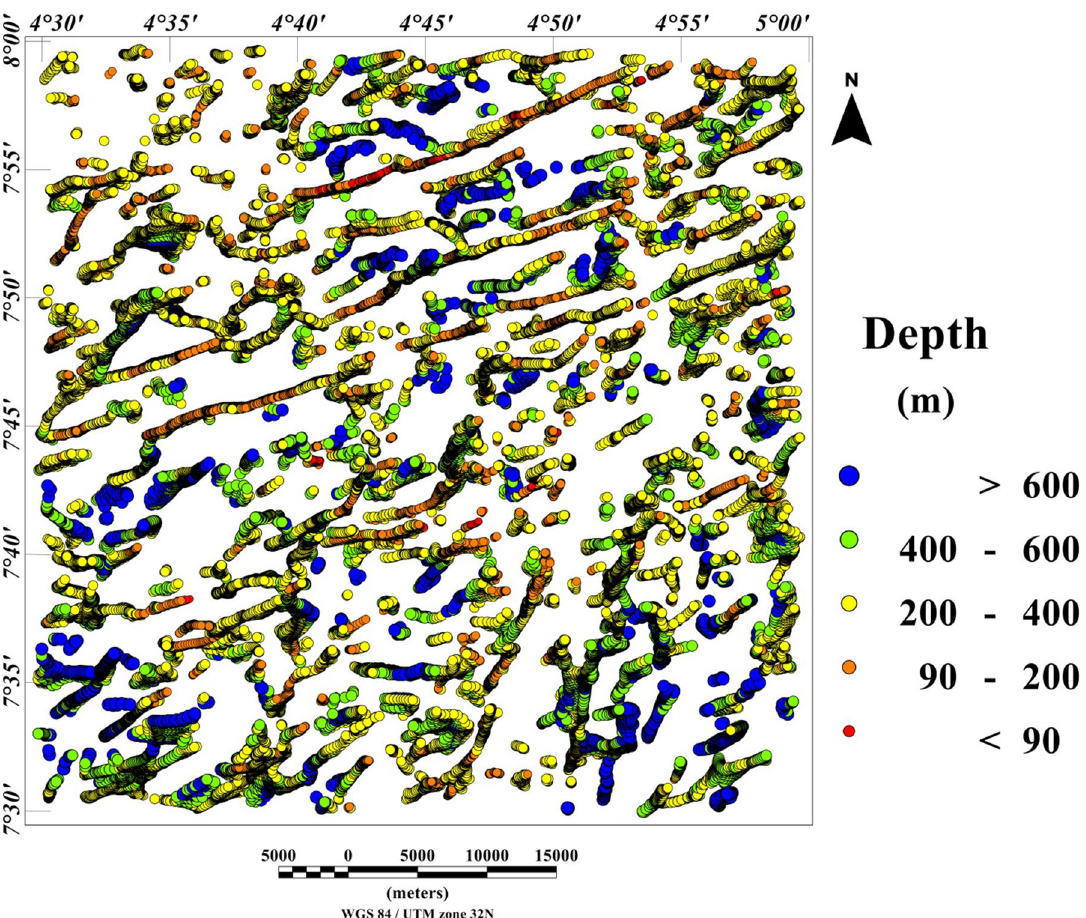
Figure 10. 3-D Euler deconvolution depth solution map generated from the total field anomaly data using SI = 1 for structural features of the Ife-Ilesha schist belt. The figure was produced using Oasis Montaj Software version 8.3.3 (Website: https:// www. seequ ent. Morphological lineaments. The shaded-relief maps of the study area are produced using the Shuttle Radar Topographic Mission elevation data. The topography features of the region are clearly depicted on the map (Figs. 4, 5). The map reveals topographical features which are controlled by subsurface structures and hence allow the automatic extraction of morphological features. In order to ensure quality interpretations and identi- fication of extension of subsurface lineaments, morphological lineaments were used in combination with mag- netic subsurface structures.